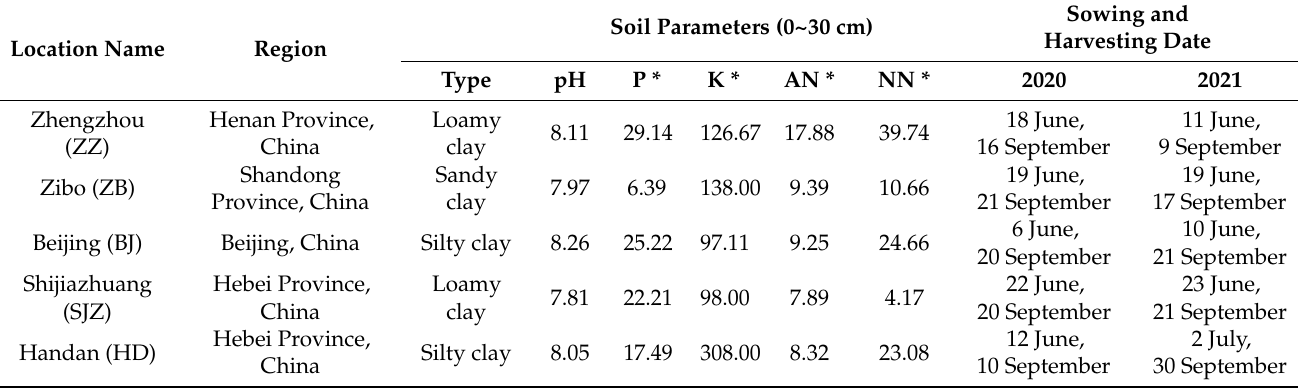
Table 2. Description of the study sites.